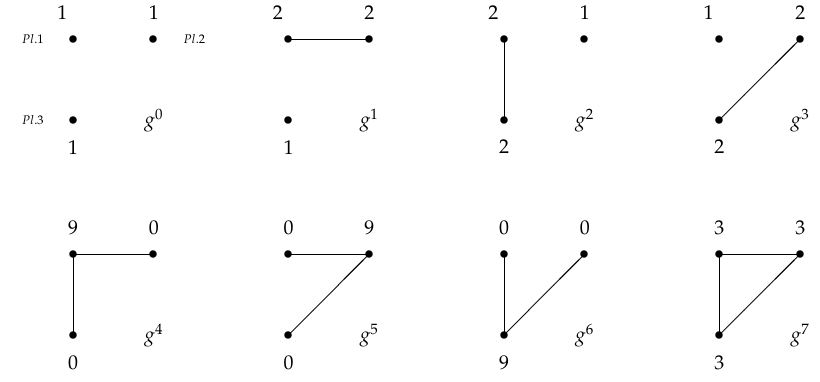
Figure 1. The 3-player criminal